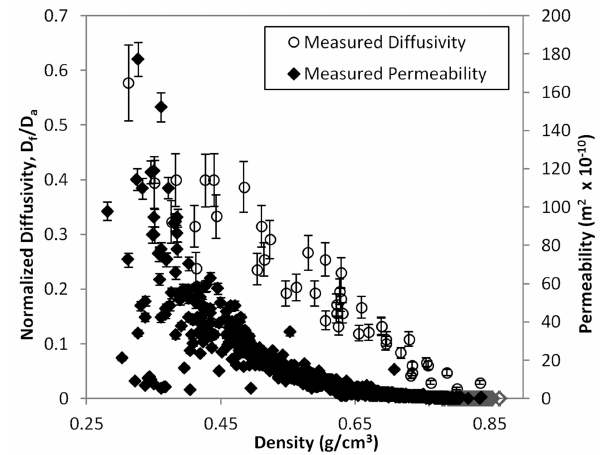
Fig. 1. Normalized diffusivity and permeability vs. density for dis- crete firn samples from Summit, Greenland. Grey diamonds indi- cate samples which were determined to be impermeable. Diffusiv- ity error bars show 13% error, estimated from repeat measurements on a single sample. Permeability error bars show approximately 5% error above 50m and 10% error below